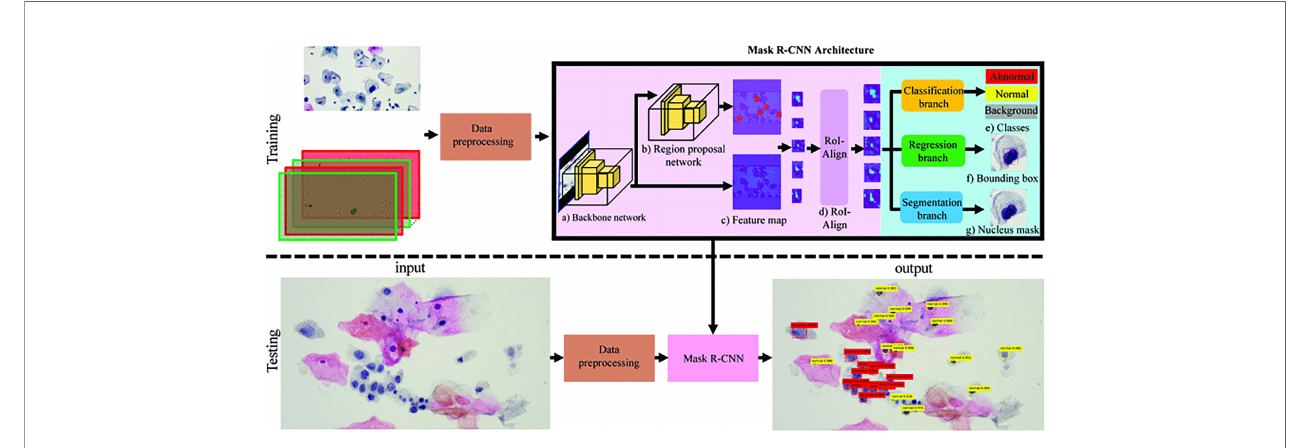
FIGURE 3 | A example segmentation model based on Mask-RCNN architecture. Reproduced with the permission of ref. (51), copyright@IEEE, 2019. In training phase, input was pap smear slide image and nucleus ground truth mask with class label was preprocessed and then trained in Mask R-CNN. In testing phase, pap smear slide image was preprocessed. Mask RCNN was used to specify bounding box, nucleus mask, and class of each